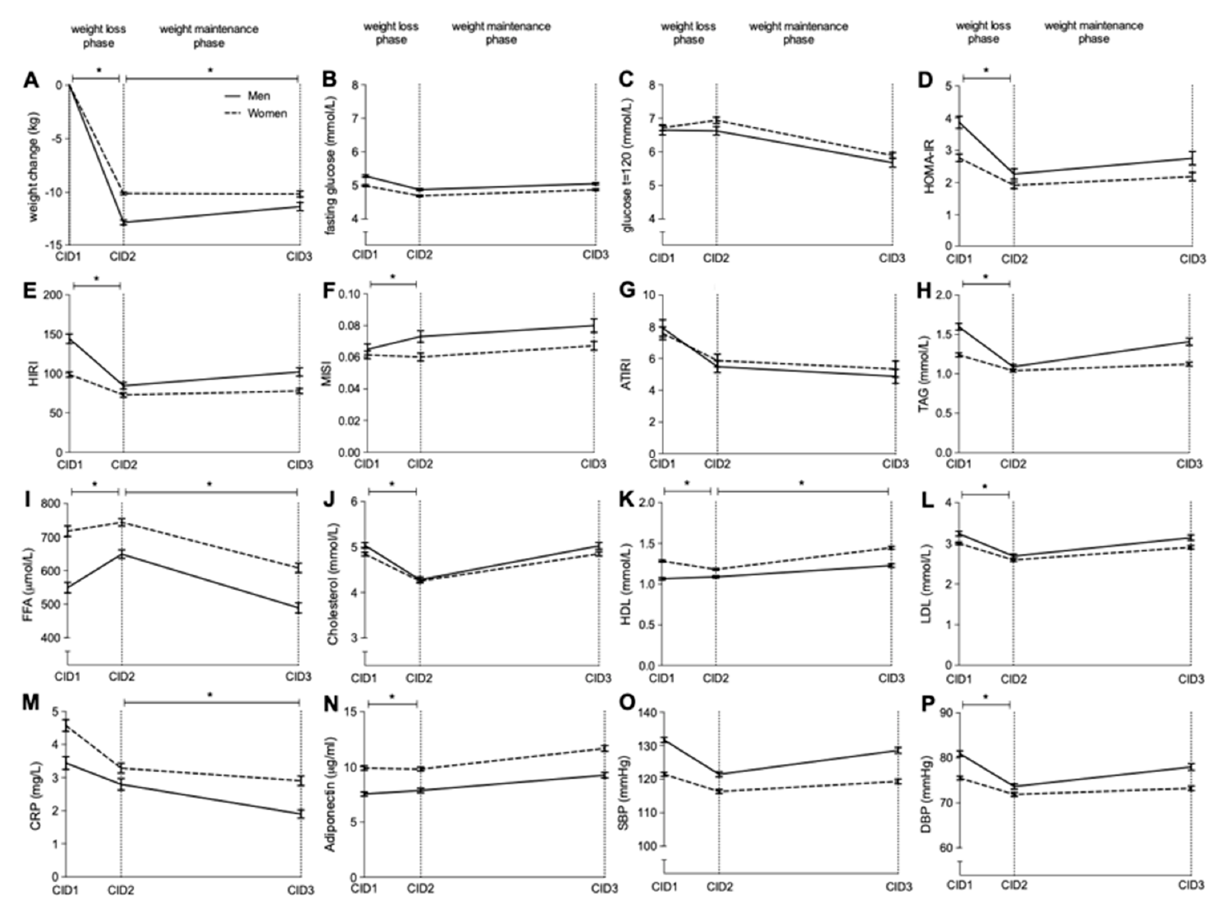
Figure 2. Mean metabolic changes in men and women following an 8-week weight loss phase (from CID1 to CID2) and after 6 months of weight maintenance (CID2 to CID3) ± standard error. Change in weight ( A ), fasting glucose ( B ), glucose t = 120, |( C ), HOMA-IR ( D ), HIRI ( E ), MISI ( F ), ATIRI ( G ), TAG ( H ), FFA ( I ), cholesterol ( J ), HDL ( K ), LDL ( L ), CRP ( M ), adiponectin ( N ), SBP ( O ) and DBP( P ) are presented.The black line represents men and the dotted line represents women. * Indicates a significant difference in change between men and women ( q < 0.05) in a linear mixed model corrected for age, body weight (changes) and baseline differences.